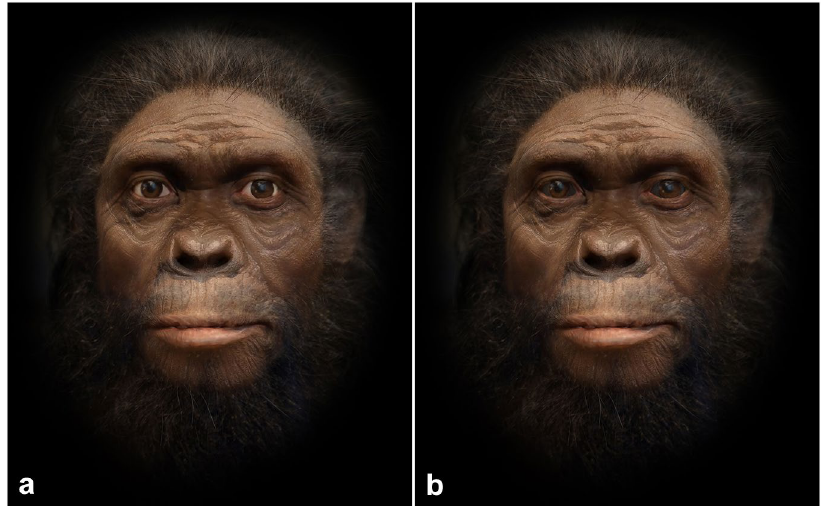
Figure 1. An example facial image used as stimulus in the bright sclera (left, + 50 PS brightness) vs dark sclera (right, −150 PS brightness) versions. Artwork by ZL, through digital editing of the following images: Fig. 7